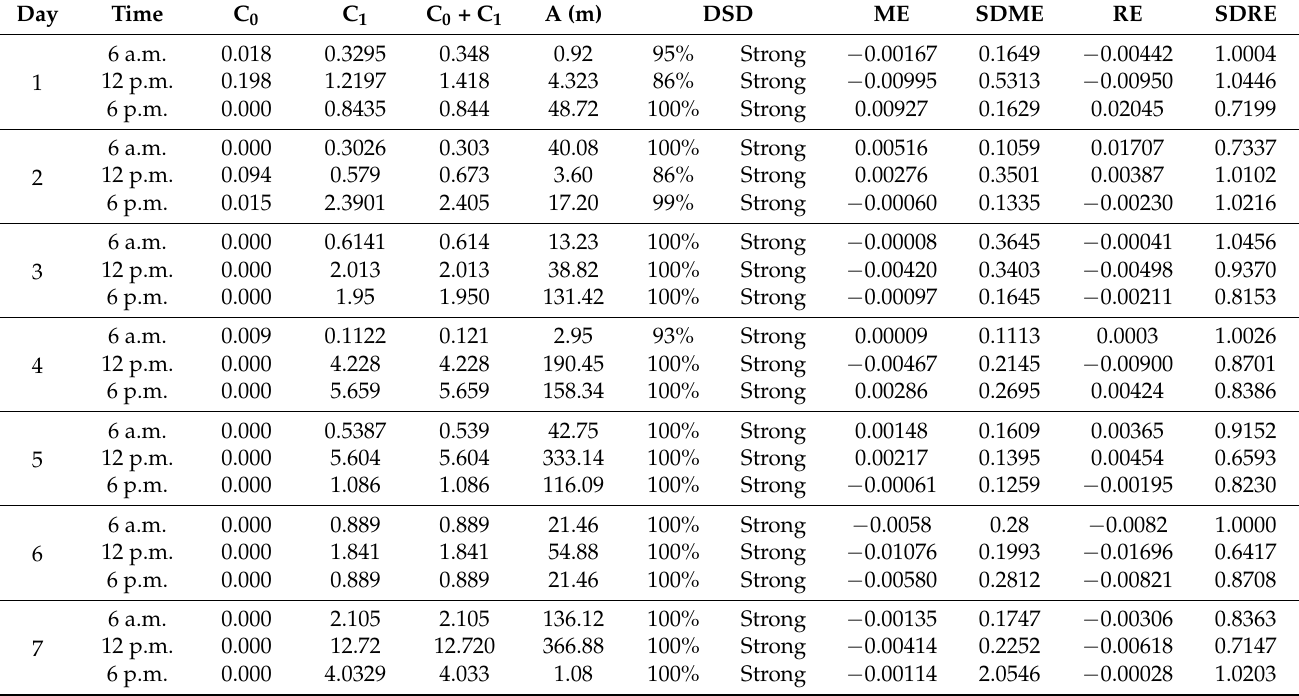
Table 1. Restricted maximum likelihood method, wave model, and estimated parameters of the experimental semivari- ograms for the temperature and humidity index (THI) in a New Zealand white (NZW) rabbit house measured over